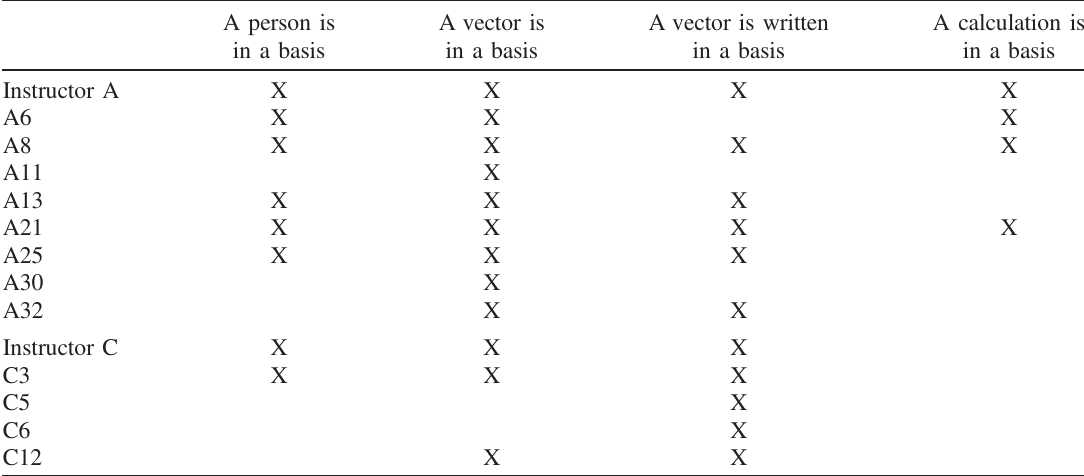
TABLE I. Each participant ’ s overall use of discourse categorized with the entities in a basis categories.